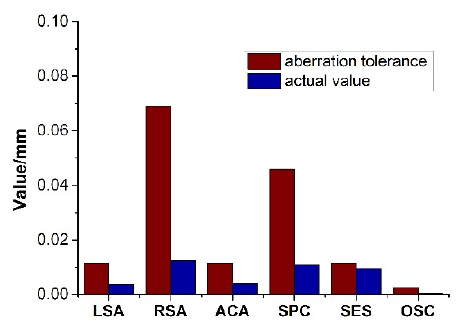
Figure 9. The tolerances and actual values of different aberrations.